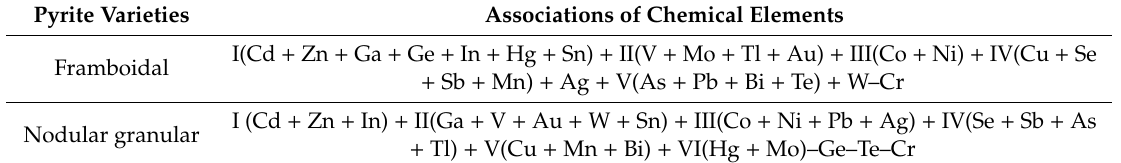
Table 3. Series of mineralogical-geochemical associations of morphogenetic pyrite varieties of the Bazhenov